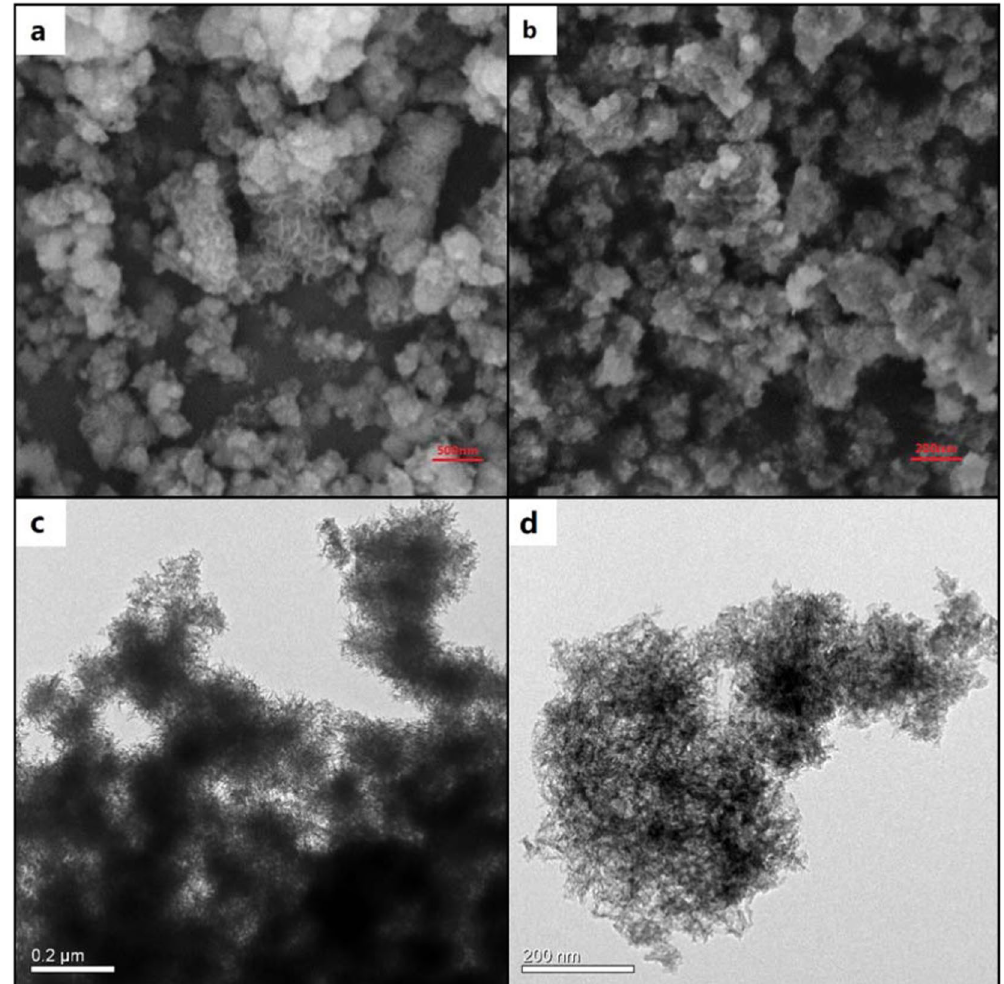
Figure 2. SEM micrographs of ( a ) ME-CoCO 3 and ( b ) CP-CoCO 3 , ( c ) low and ( d ) high magnification TEM micrographs of